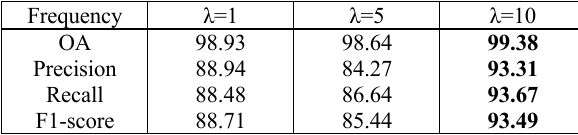
Table 2. Objective evaluation for proposed method Auto-GAN with different values of